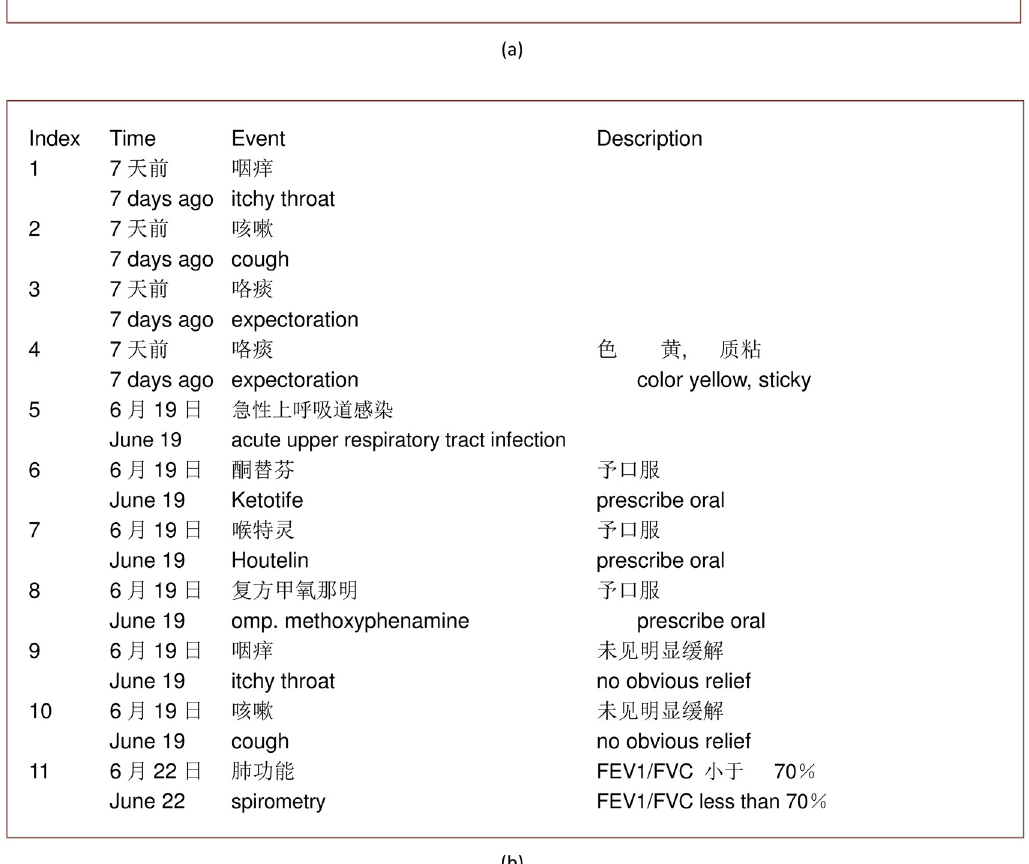
PLOS ONE | DOI:10.1371/journal.pone.0136270 August 21,